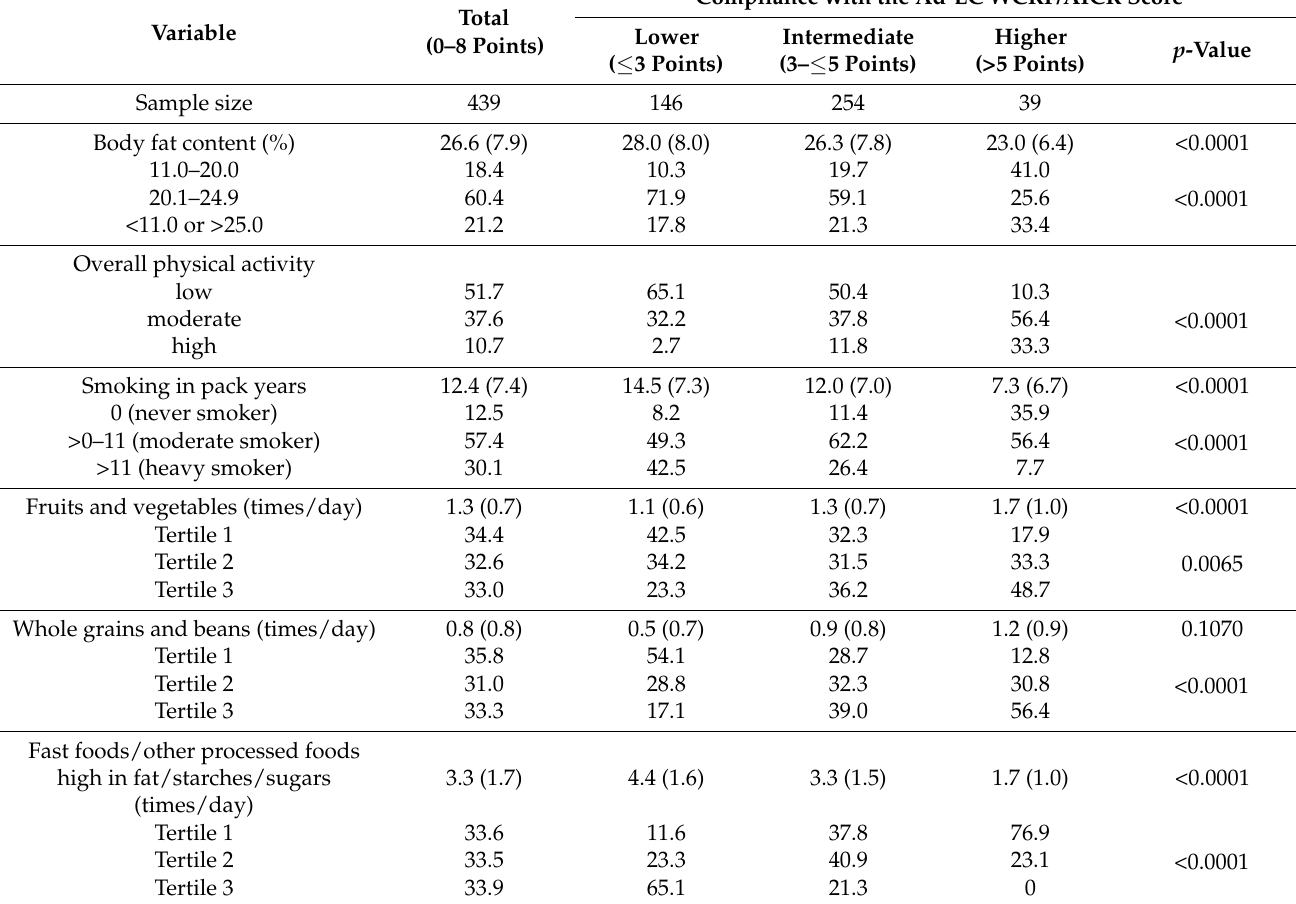
Table 6. Components of the Ad-LC WCRF/AICR Score by categories of compliance with this score in the cancer-control sample: means (SDs) and sample distribution